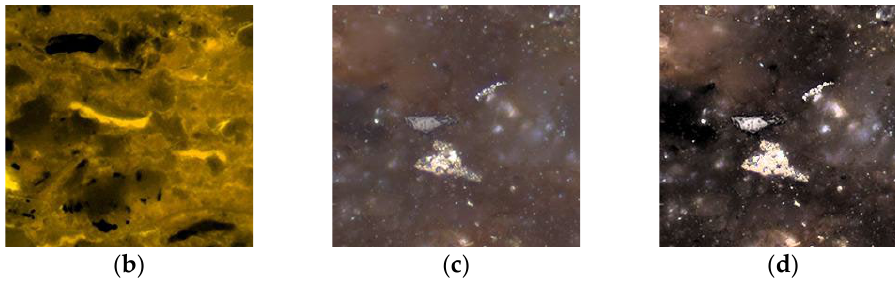
Figure 3. Color space transformation. ( a ) Fluorescent-light photomicrograph in RGB space; ( b ) fluorescent-light photomicrograph in HSV space; ( c ) reflected-light photomicrograph in RGB space; and ( d ) reflected-light photomicrograph in HSV space.